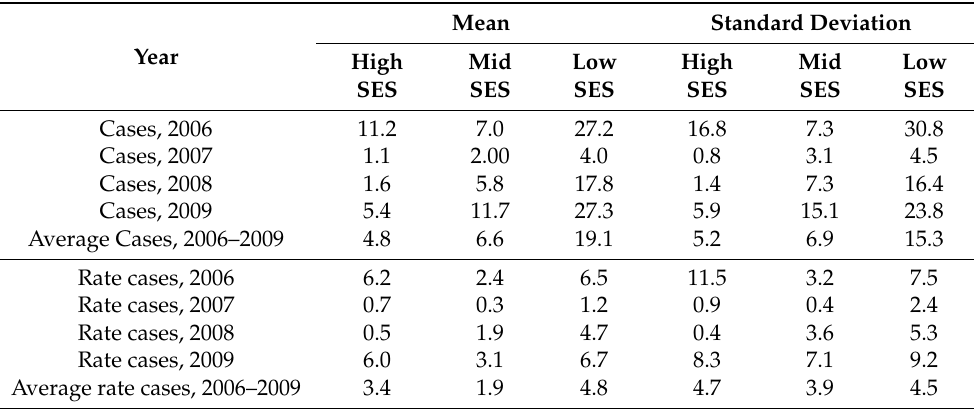
Table 1. Average number of dengue fever cases and case rate per 10,000 people by neighborhood socioeconomic status in Jeddah City,